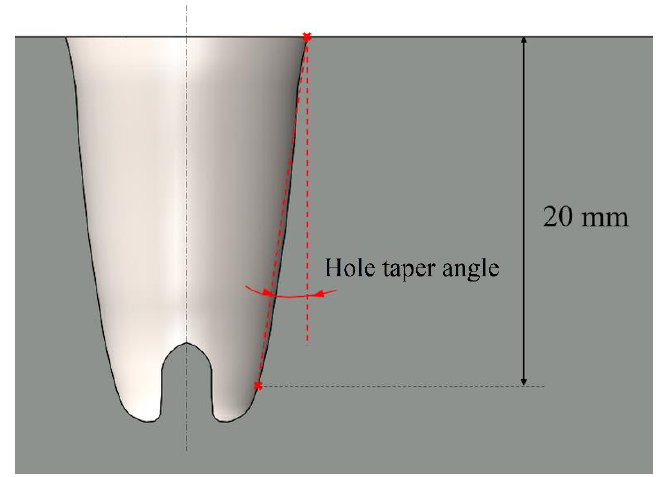
Figure 9. The geometrical definition of the hole taper angle.